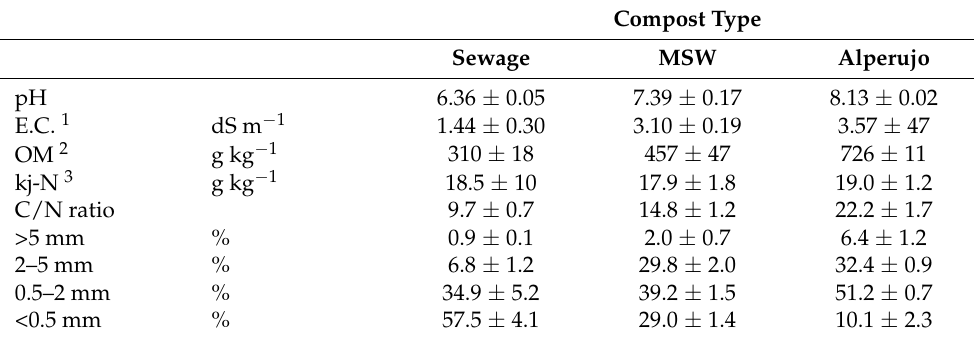
Table 1. Compost characteristics ( ± standard deviation).